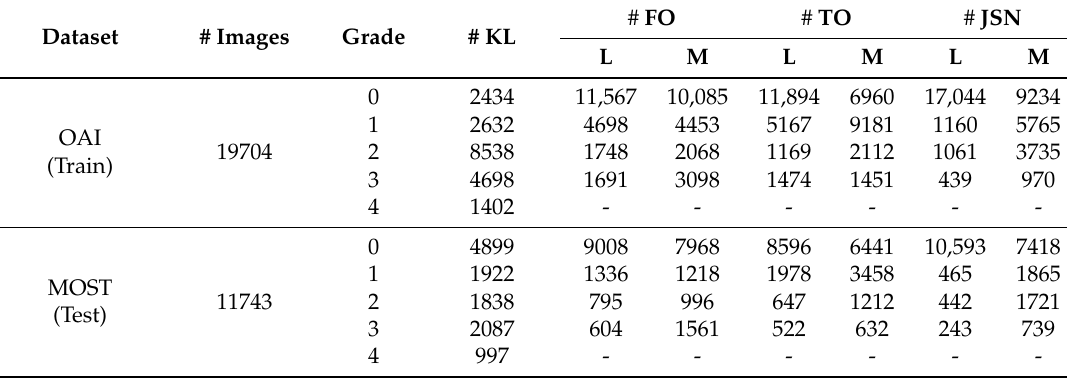
Table 1. Description of the datasets used in this study. We used all the follow-up examinations from Osteoarthritis Initiative (OAI) and Multi-Center Osteoarthritis Study (MOST). L and M indicate lateral and medial compartments, FO and TO indicate femoral and tibial osteophytes and JSN indicates joint space narrowing. KL indicates the Kellgren–Lawrence grade. # sign stands for the amount of data. # FO # TO # Dataset # Images Grade # KL